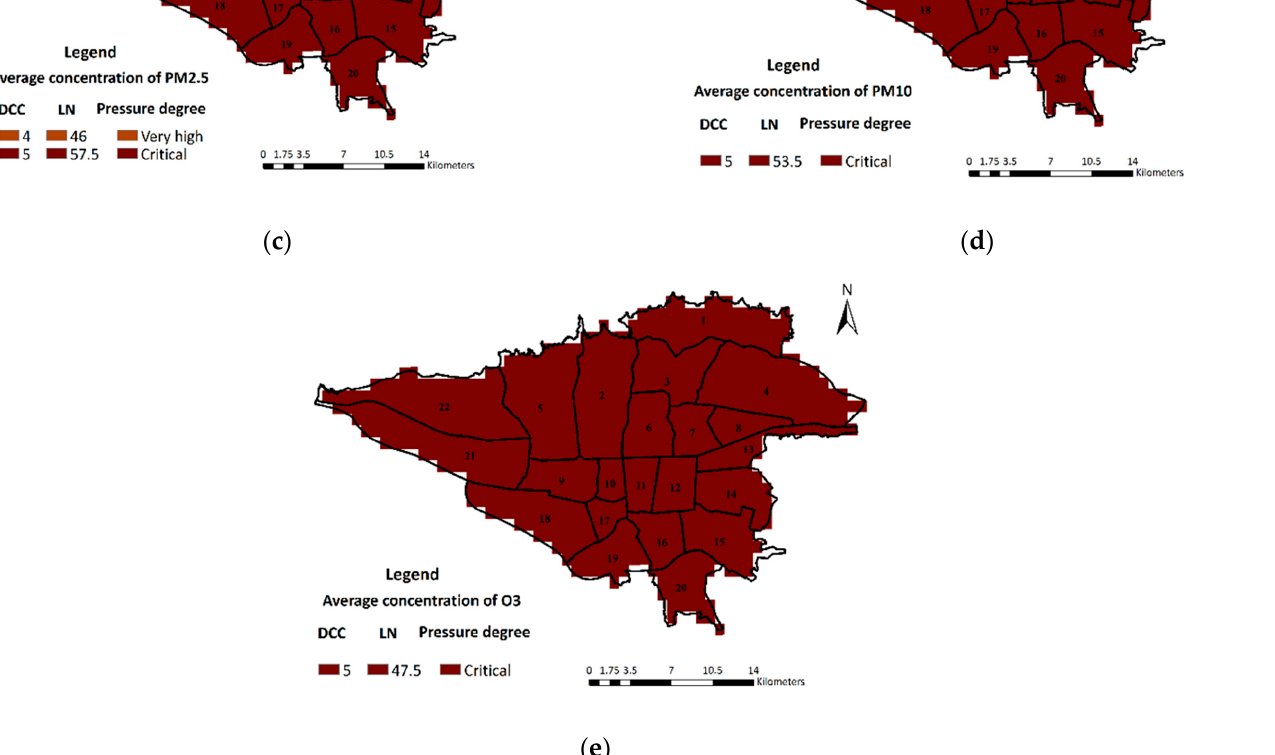
2 ; ( b ) SO 2 ; ( c ) PM 2.5 ; ( d ) PM 10 ; ( e ) O 3